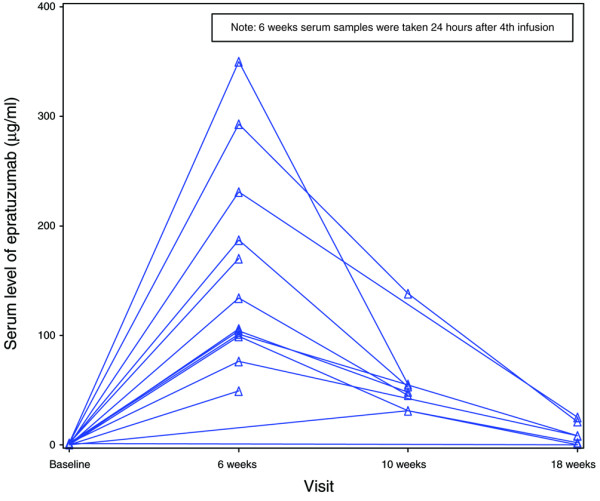
Serum levels of epratuzumab as detected by ELISA in the patients during the study.